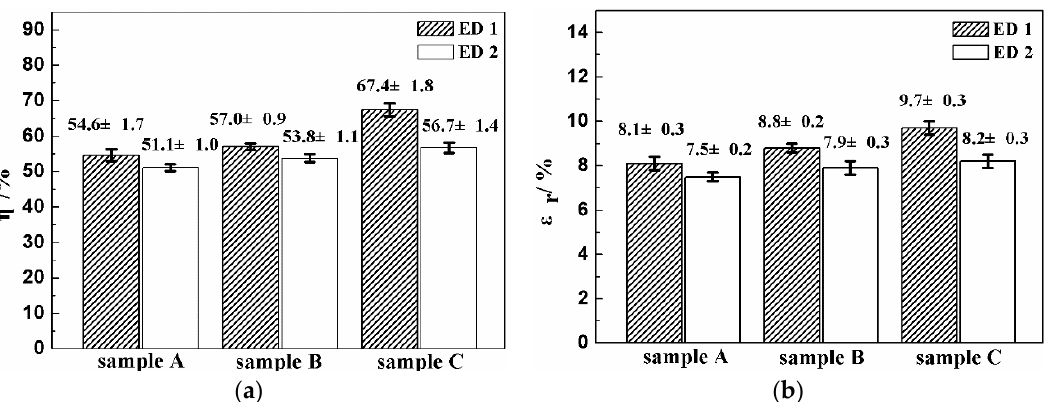
Figure 7. Recoverability of Samples A, B and C along the expansion directions of ED1 and ED2: ( a ) recovery rate η and ( b ) recovery strain ε r .